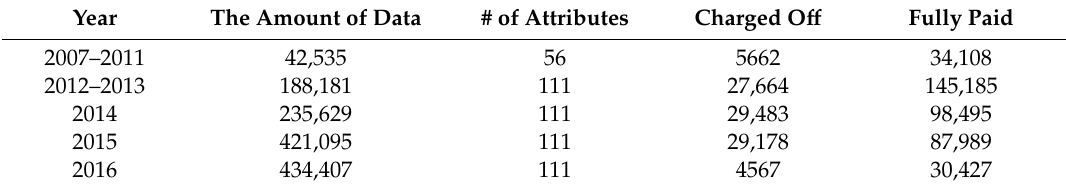
Table 1. The statistics of Lending Club data.